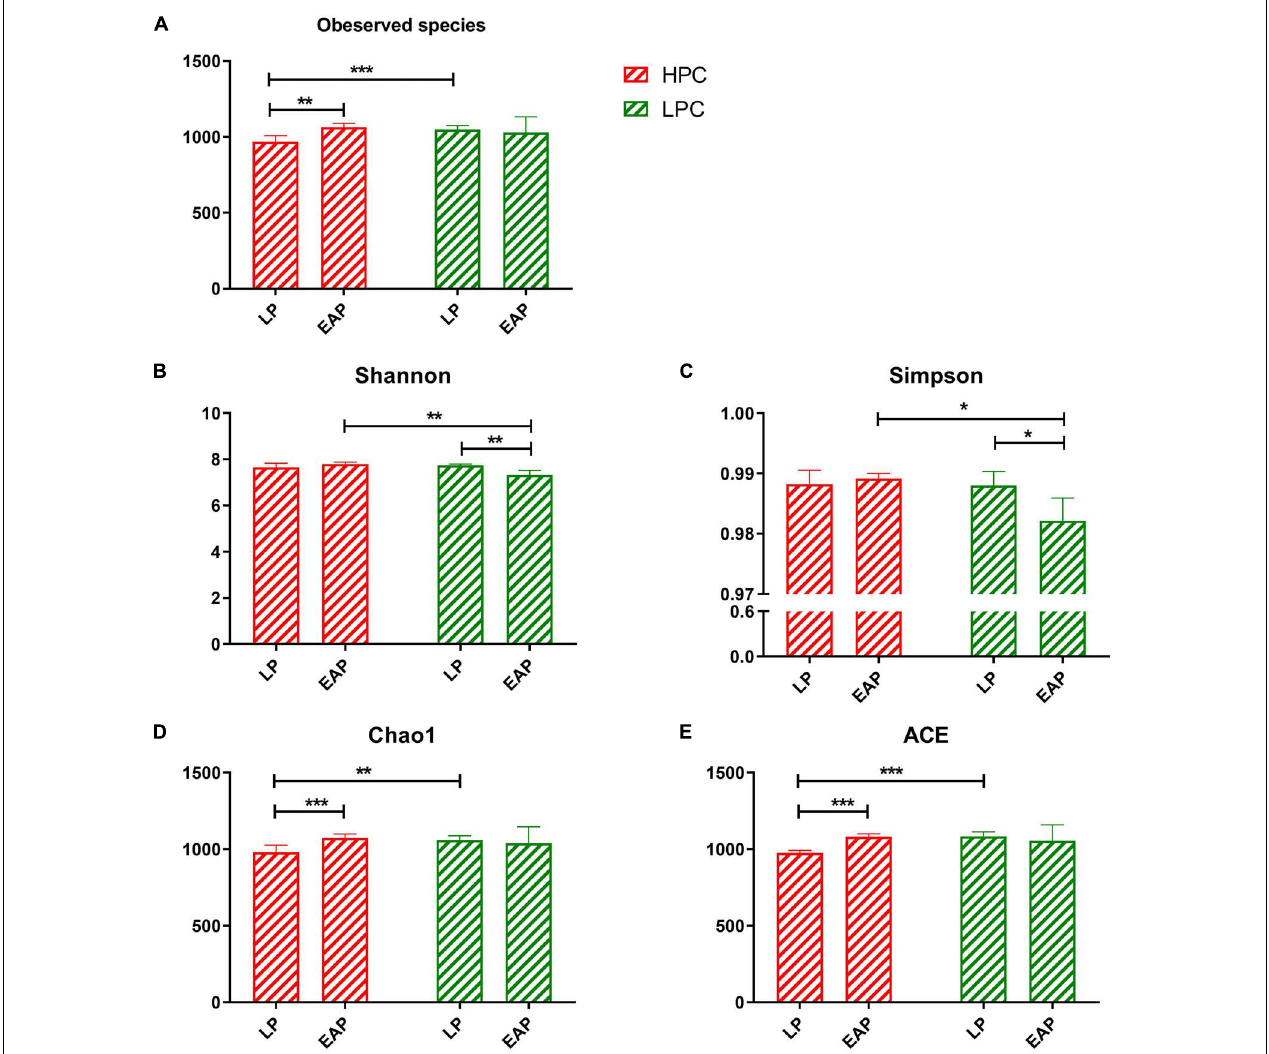
FIGURE 1 | Alpha diversity and richness of gut microbiota from high productive capacity (HPC) and low productive capacity (LPC) sows at late pregnancy (LP) and early stage after parturition (EAP) stage. (A–E) Indices for alpha diversity and richness. Paired T -test (LP vs. EAP) or independent T -test (HPC vs. LPC) was used after accessing normality with Shapiro–Wilk W -test. Data are presented as mean ± SD ( n = 6), ∗ P < 0.05, ∗∗ P < 0.01, ∗∗∗ P < 0.001.